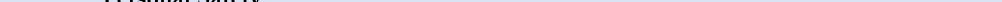
Table A2. Cont. Personal